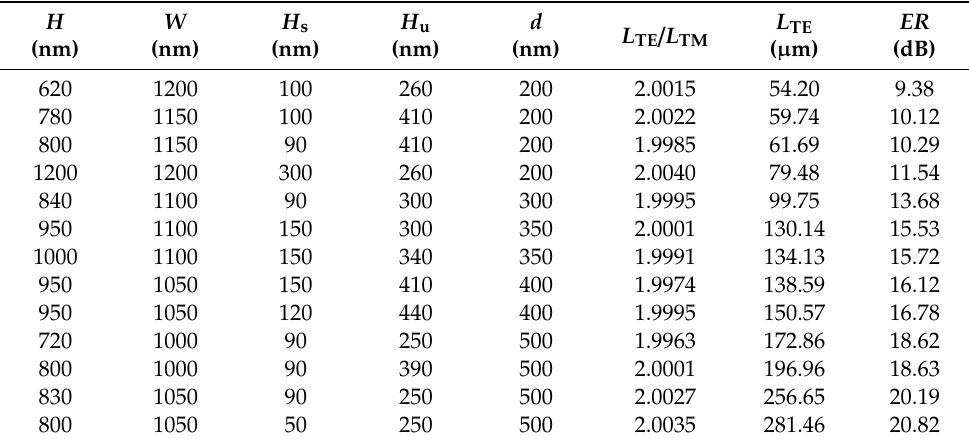
Figure 12. The tradeoff between the extinction ratios (ER) and coupling length of single-slot-waveguide-based PBS (square) and multi-slot-waveguide-based PBS (triangle). Table 1. Optimized Parameters of the Single-Slot Waveguide-Based PBS.